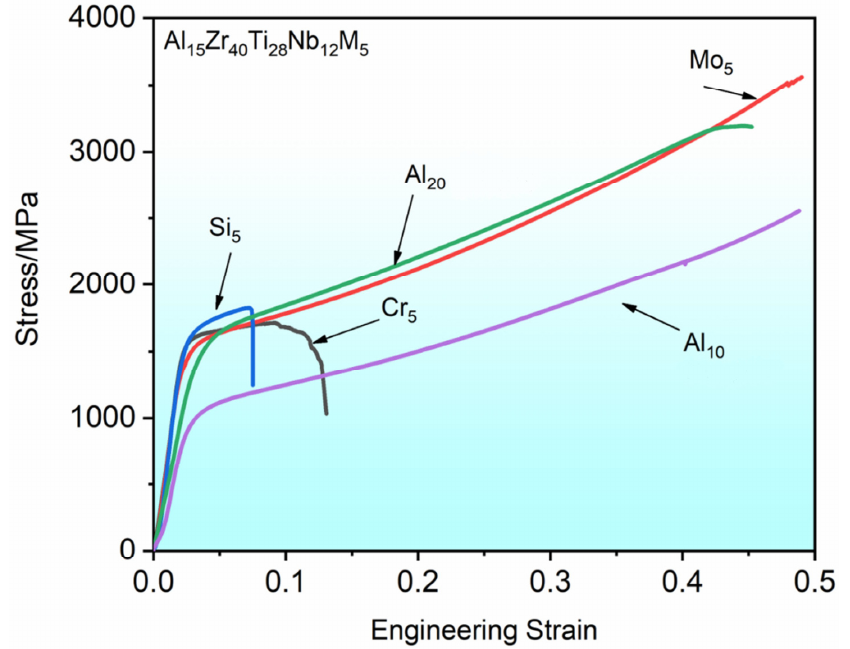
Figure 5. Compressed stress–strain curves of the Al 15 Zr 40 Ti 28 Nb 12 M 5 (Cr, Mo, Si) HEAs and Al x (Zr 50 Ti 35 Nb 15 ) 100 − x [15] HEAs (reproduced from Ref. [15], with permission from Elsevier,